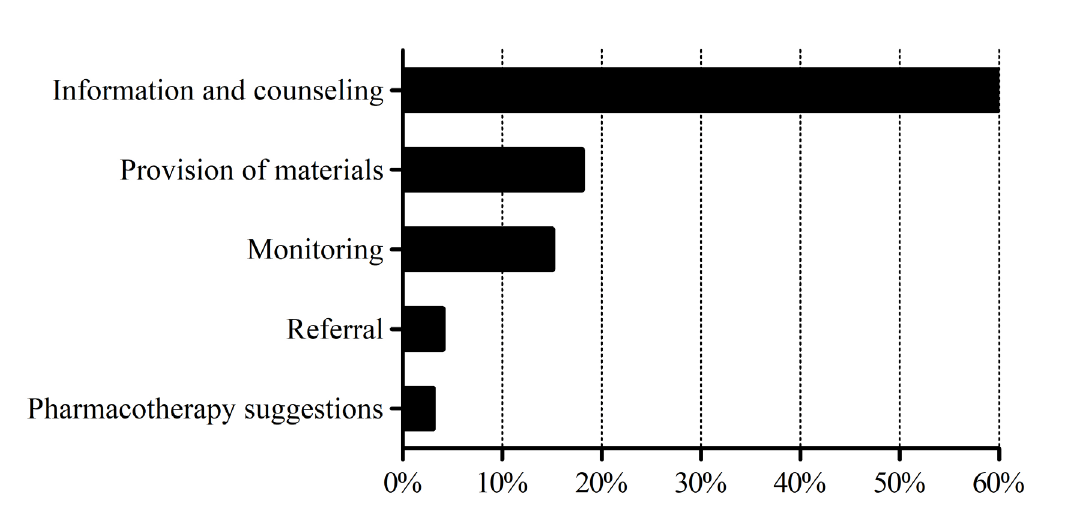
FIGURE 3 - Analysis of Pharmacist Interventions by category (n=437).